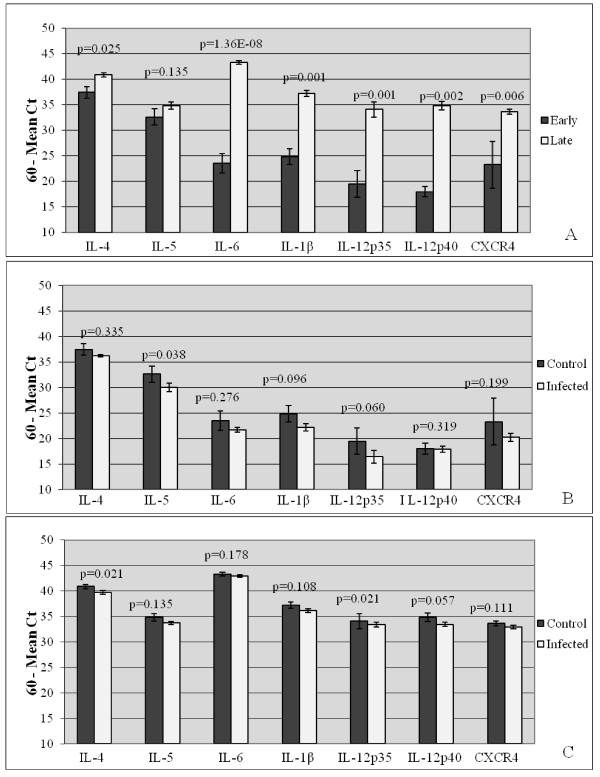
Relative Expression of Immunomodulators in Trophoblasts from Early-and Late-Term Feline Placentas. Real-time RT-PCR analysis of feline placental trophoblast expression of the pro-inflammatory cytokines (IL-6, IL-1β, IL-12p35, and IL-12p40), the anti-inflammatory cytokines (IL-4 and IL-5), and the chemokine receptor (CXCR4) in: (A) early-term uninfected placentas (n = 3) versus late-term uninfected placentas (n = 3); (B) early-term FIV-infected (n = 5) versus uninfected placentas; (C) late-term FIV-infected (n = 5) versus uninfected placentas. Bars represent mean Ct values substracted from a negative endpoint (60-mean Ct), bracketed by standard errors of the mean. P values obtained from single factor ANOVA and Wilcoxon rank sum test are noted. P values ≤ 0.05 were considered significant.